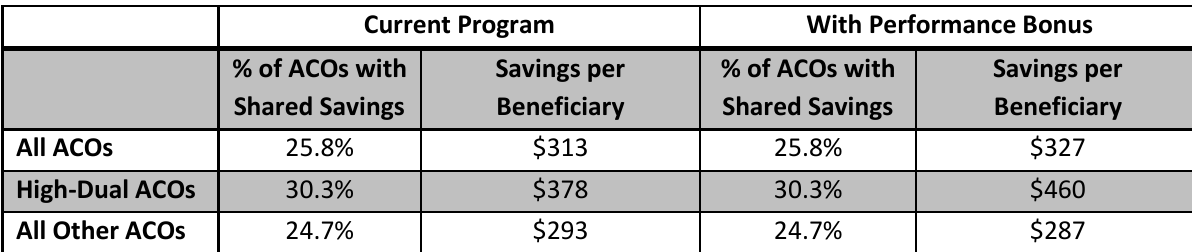
Table 9.14: Simulated Effects of Bonuses for High-Performing ACOs serving beneficiaries with social risk factors in the Medicare Shared Savings Program Current